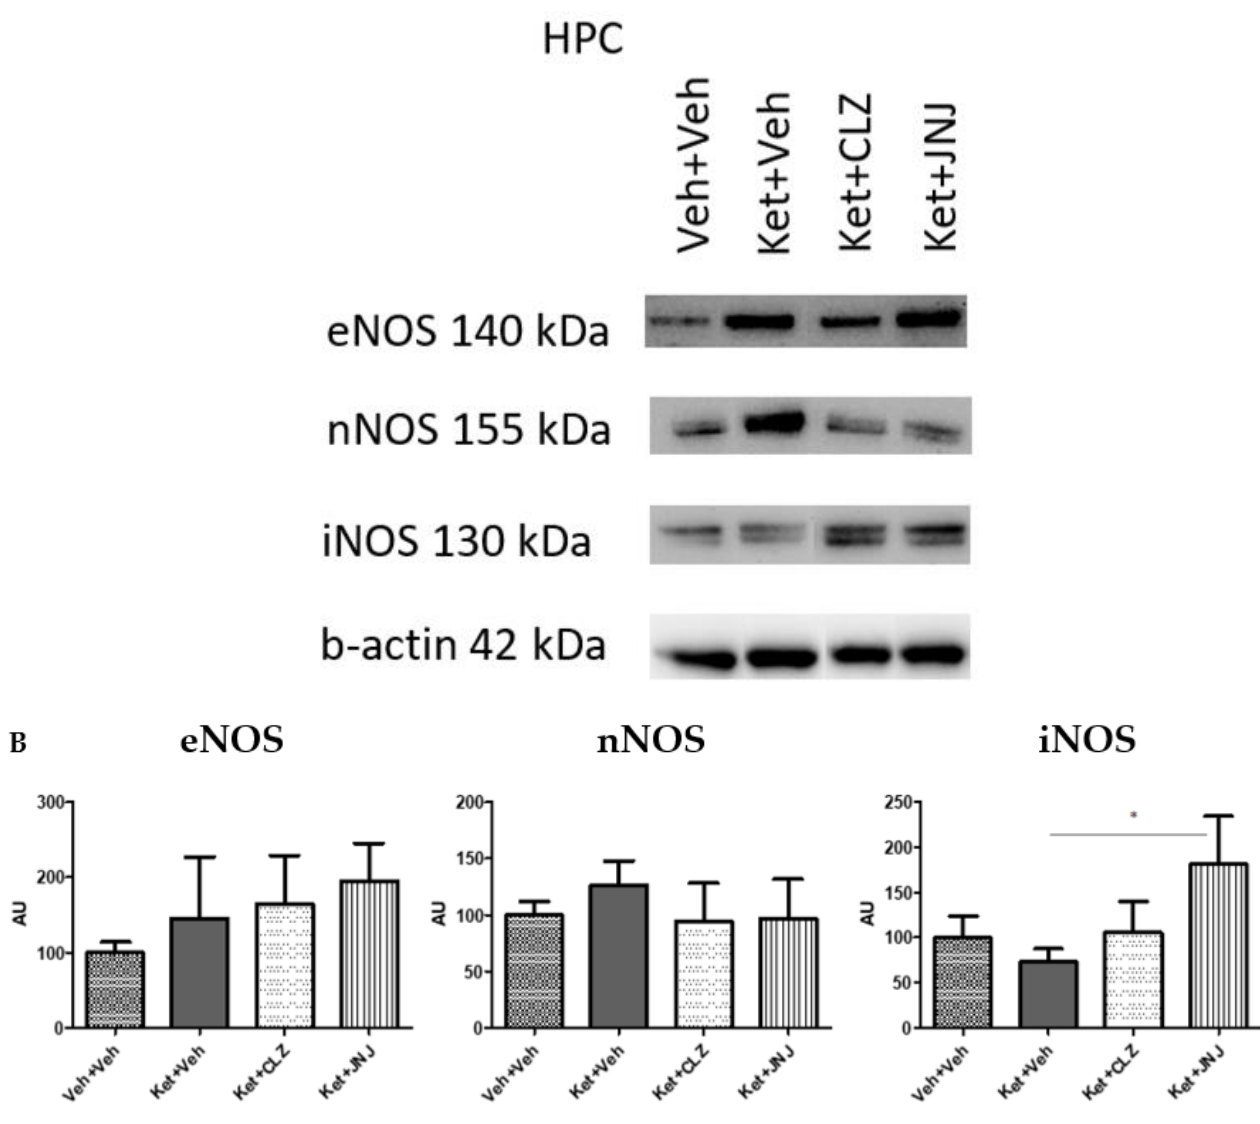
Figure 2. Effect of CLZ and JNJ treatments on protein levels of NOS isoforms in the HPC of SZ-like mice induced with Ket. ( A ) Representative densitometry blots of eNOS, nNOS, and iNOS isoforms in the HPC tissue from the different groups of study, including vehicle controls, SZ-like mice induced with Ket, and Ket-induced mice treated with CLZ or JNJ. The upper panels show the three protein isoforms of interest, and the lower panel represents the corresponding housekeeping β -Actin. ( B ) Protein levels of the three NOS isoforms (eNOS, nNOS, and iNOS) were estimated by quantification of densitometry blots (AU). No significant differences were obtained in the protein levels of eNOS and nNOS isoforms. Protein levels of the inducible iNOS isoform significantly increased in the Ket-induced group treated with JNJ compared to the Ket-induced SZ-like group. * p < 0.05 (AU, arbitrary units; CLZ, clozapine; eNOS, endothelial nitric oxide synthase; HPC, hippocampus; iNOS, inducible nitric oxide synthase; JNJ, JNJ-46356479; Ket, ketamine; NOS, nitric oxide synthase; nNOS, neuronal nitric oxide synthase; Veh,